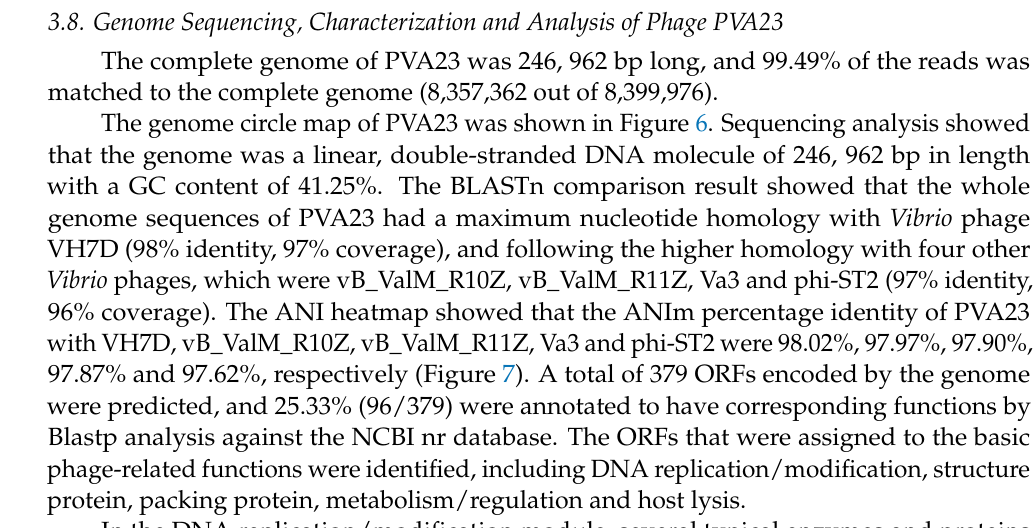
Table 5. The result of the BIMF of V. alginolyticus VA15 to phage PVA23.